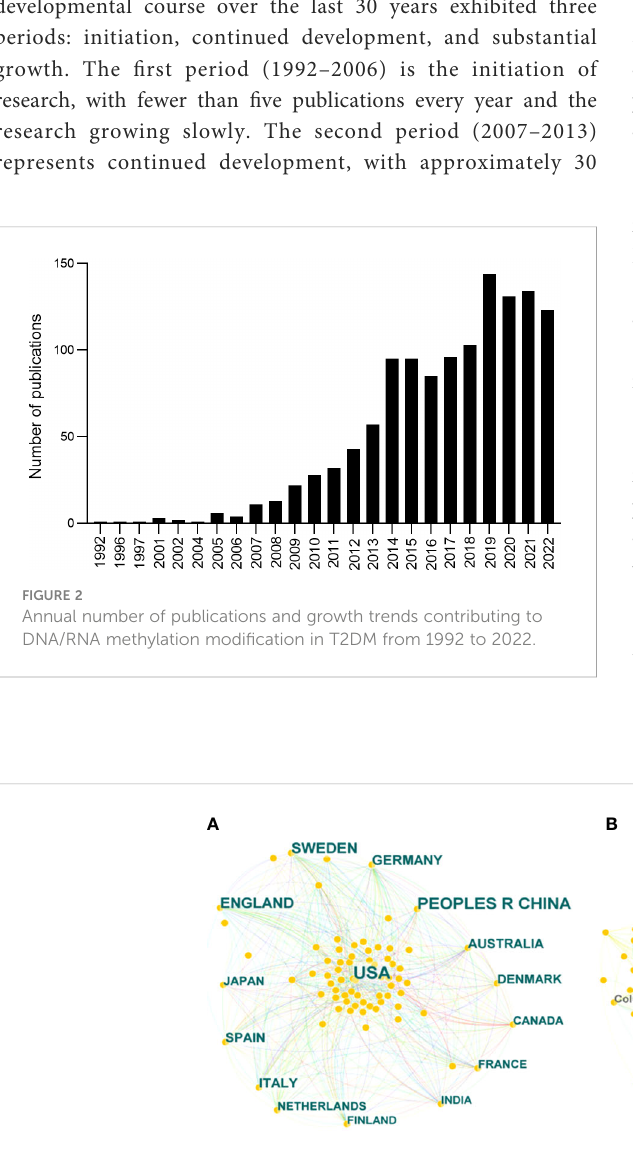
FIGURE 3 Bibliographic analysis of the scienti fi c collaboration network. (A) Collaboration among countries/regions. (B) Collaboration among institutions. Different sizes denote the quantity of publications for countries or institutions, and the distance between the two circles represents the relatedness between